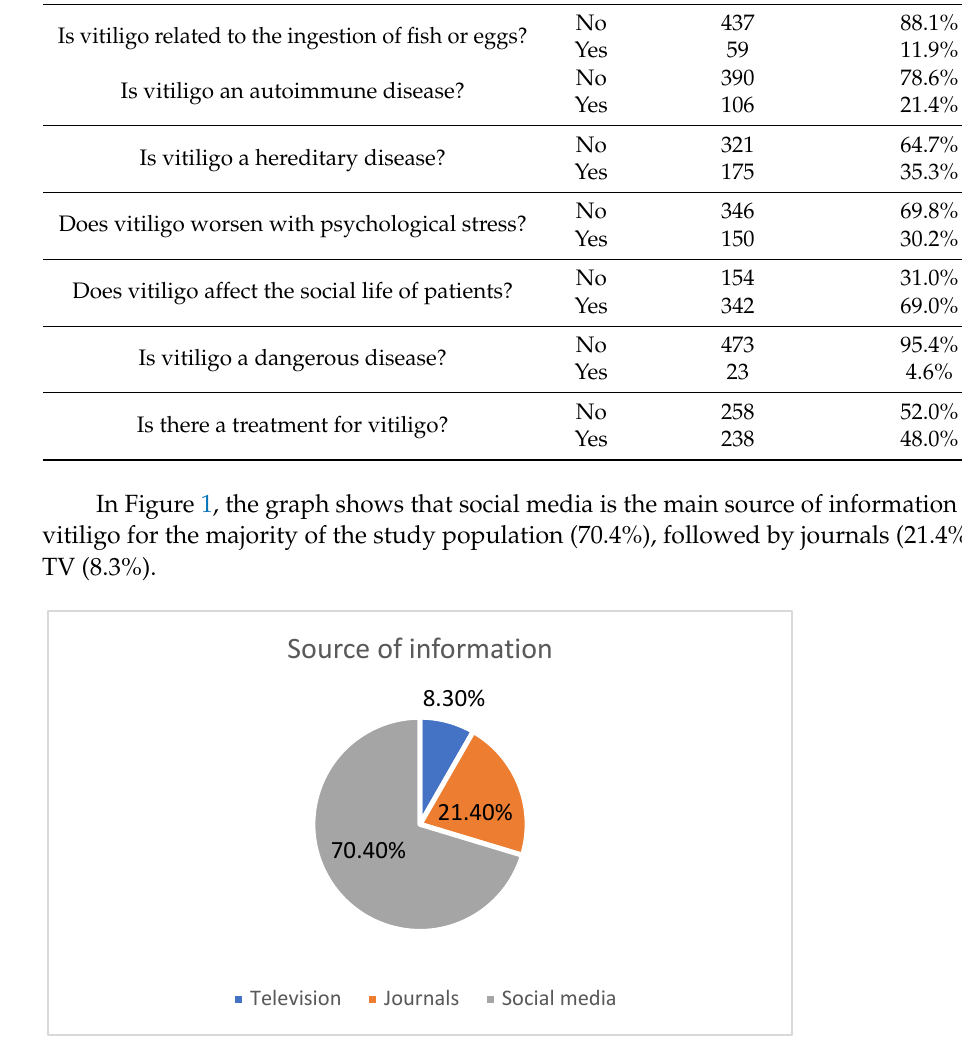
Figure 1. Source of information on vitiligo.